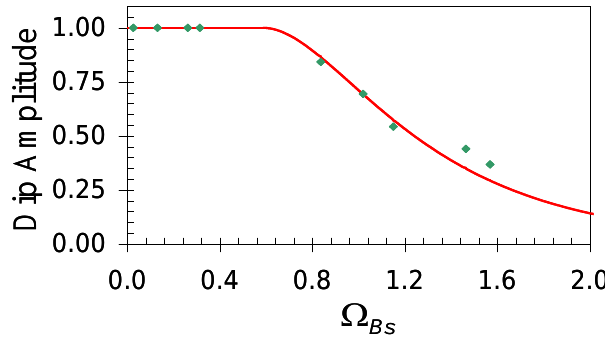
Figure 6. Normalized Brillouin loss spectrum dip plotted as a function of the normalized Brillouin frequency shift. Simulation results (plain curve) and experimental data (diamond) at the middle of sensing length 40 m, Ppump = 5 mW, Pcw = 3 mW, pulse length of 20 cm, ER = 11 dB [31] (Copyright © 2005 IEEE, Reprinted with